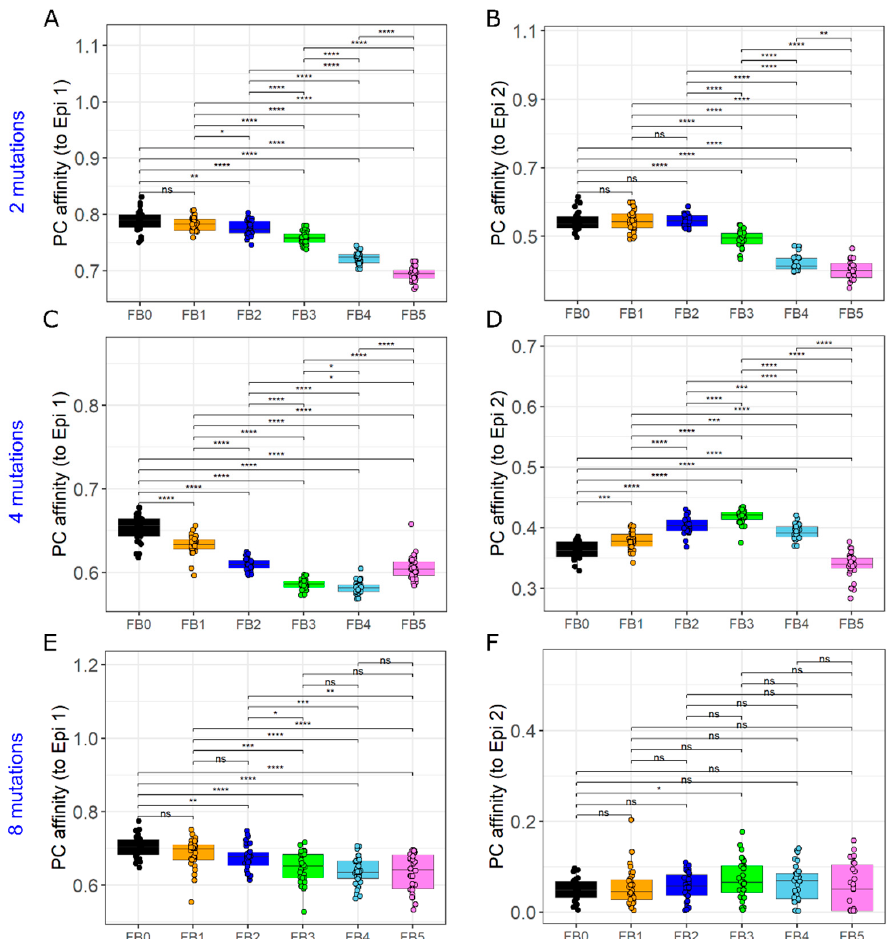
Figure 7. GC responses to antigenic variants. Affinity of plasma cells from all GCs to epitope 1 ( A , C , E ) and epitope 2 ( B , D , F ) at day 25 of the GC reaction. Mutation distance of epitope 2 with respect to epitope 1 is 2 ( A , B ), 4 ( C , D ) or 8 ( E , F ). Colors represent different GC–GC interaction strengths. FB0 represent simulations with no GC-GC interaction. FB1 and FB2 represent one-tenth and one-third of low interaction strength, respectively. FB3, FB4 and FB5 correspond to low, medium and strong interaction strengths, respectively. GCs were initialized with epitope 1 (shape space position 3333) and an antigenic variant (epitope 2) with mutation distance of 2, 4 or 8 (shape space positions 3344, 4444 and 5555, respectively) from epitope 1 was added from day 7 of GC